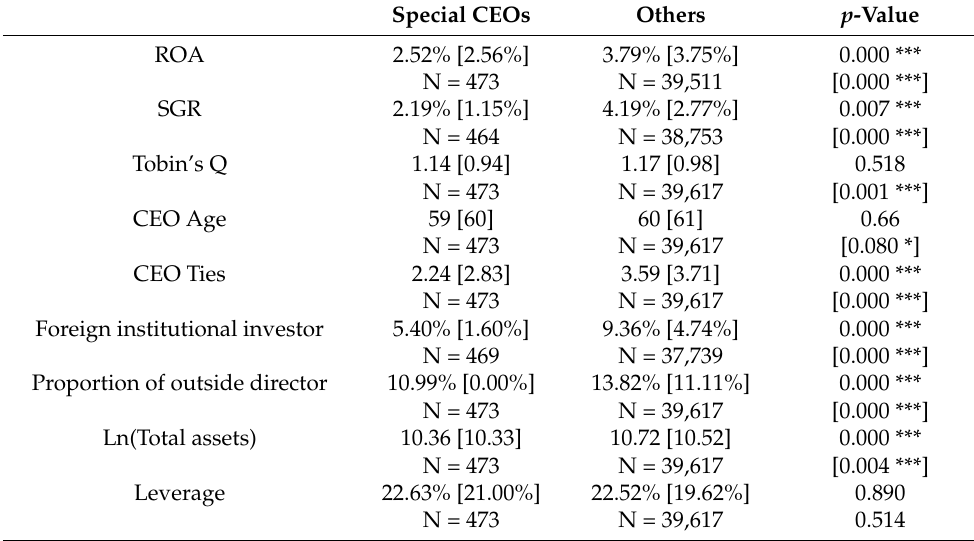
Table 2. Summary